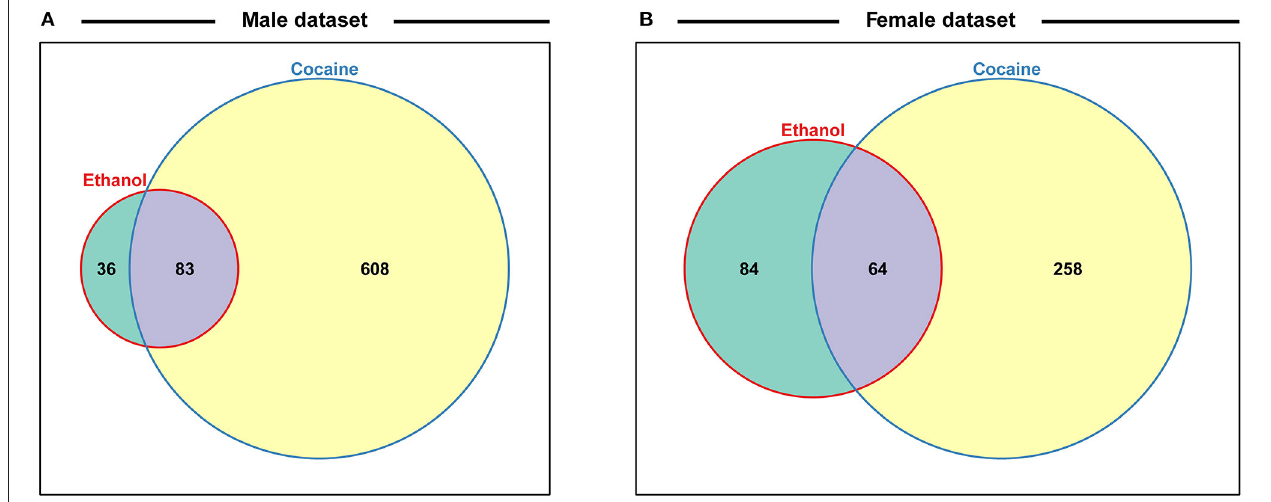
FIGURE 7 | Venn diagrams indicating the proportions of differentially regulated genes after exposure to alcohol during development or acute consumption of cocaine for males (A) and females (B). Data for cocaine exposure are from ref 19. See also Supplementary Table 7